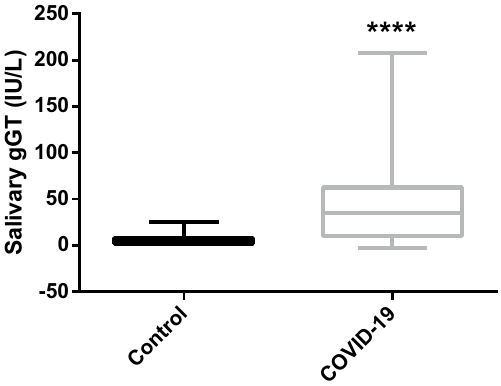
Figure 6. Salivary gamma glutamyl-transferase concentrations in the saliva of COVID-19 patients (n = 66) and control group (n = 32). The plot shows the median (line within box), 25th and 75th percentiles (box), and 10th and 90th percentiles (whiskers). Asterisk indicates a significant difference between groups: ***p < 0.001. gGT: gamma glutamyl-transferase. Source: Prism 9.3, GraphPad software (https:// www. graph pad. com).